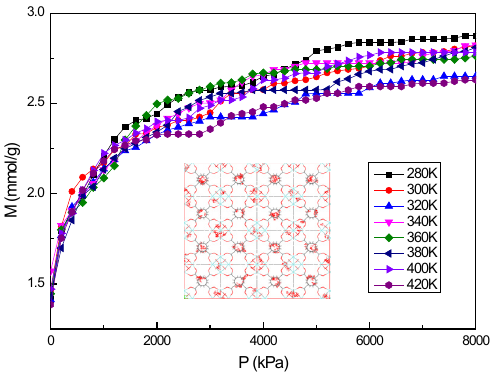
Figure 3: Molecular structure of R125.